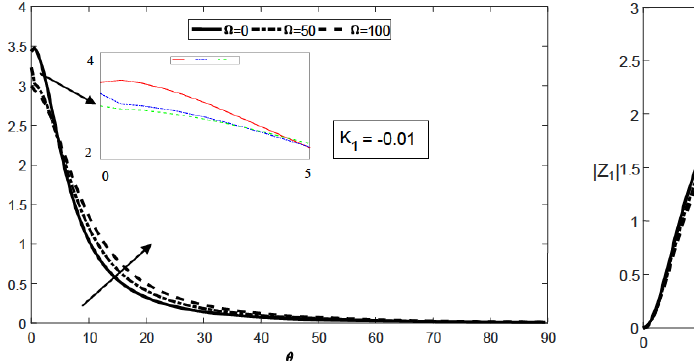
Figure 6: The amplitude ratio of first wave against incident angle for different variable thermal conductivity